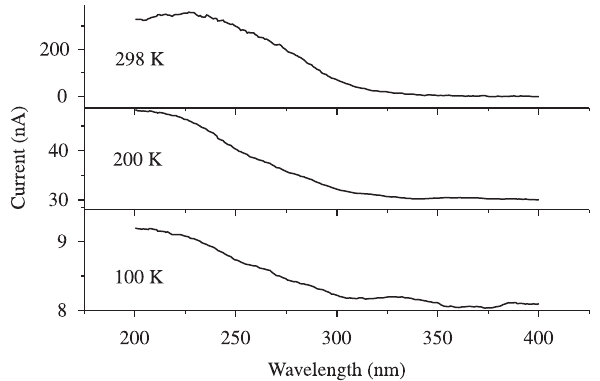
Figure 4. Excitation of photoconductivity spectra for SnO at distinct